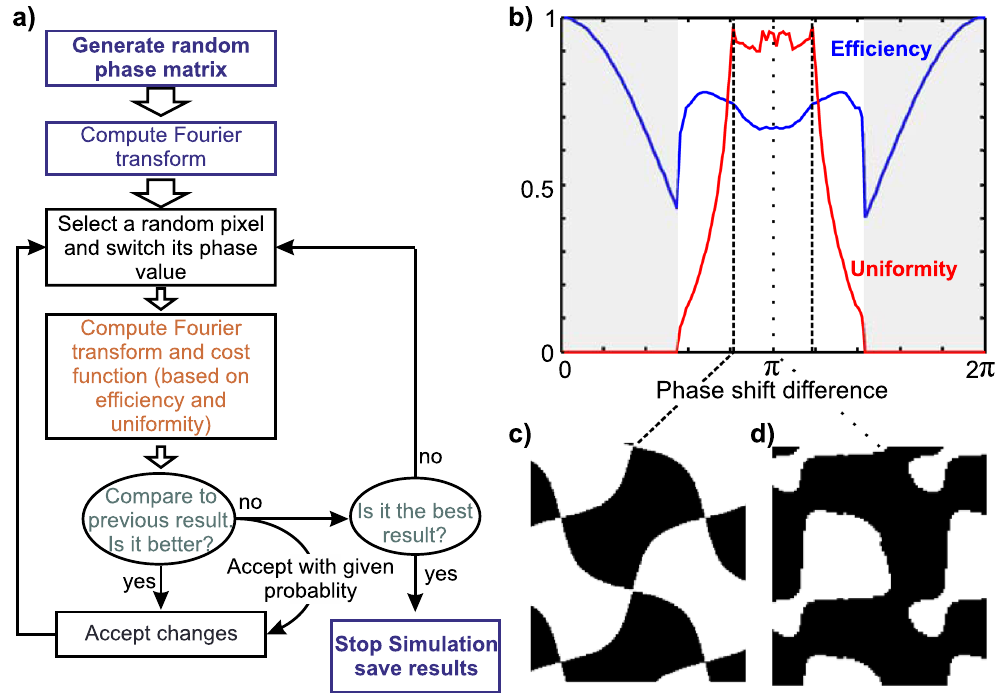
Figure 1. Simulation pipeline for phase grating. ( a ) Diagram for computational iterations to generate phase grating profiles for specific spot distribution. ( b ) Diffraction efficiency and uniformity of spots intensity for 3 × 3 array generator reported for each solution found for a specific phase shift. ( c ) The obtained phase grating motif, white and black colors correspond to 0 and 0.84 × π phase shifts simultaneously. ( d ) The simulated grating motif for a π phase